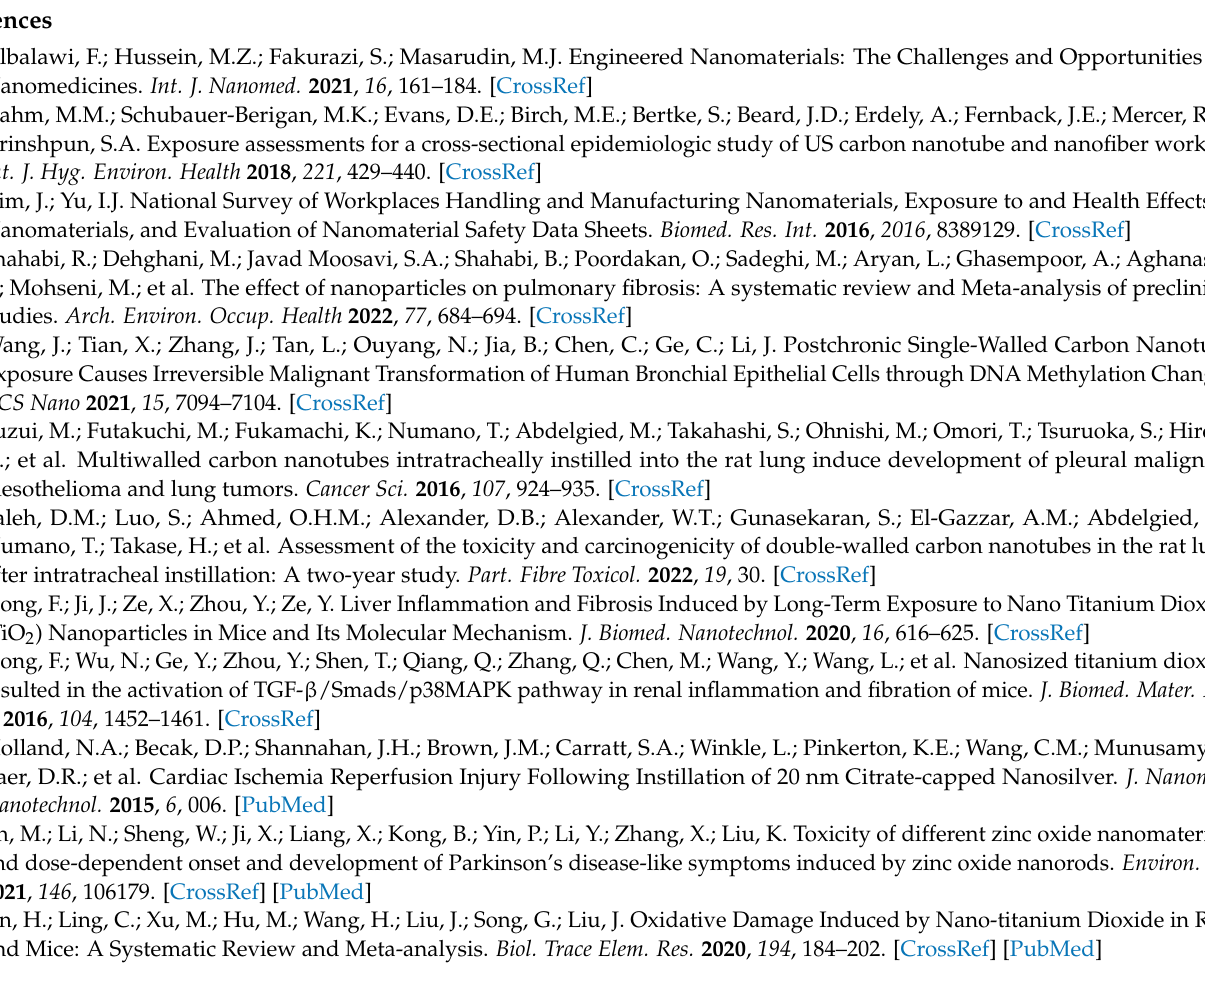
Table S2: Subgroup analysis for oxidative stress biomarkers, Table S3: Subgroup analysis for inflam- matory